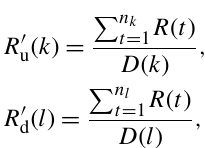
Figure 5. Normalised wind power ramps, R ( t ), are superimposed over the normalised wind power values P ( t ) for the 10d period discrimi- nated at the 10% (a) , 5% (b) , 2% (c) , and 1% (d) levels. Ramp-up events are shown in red and ramp-down events in